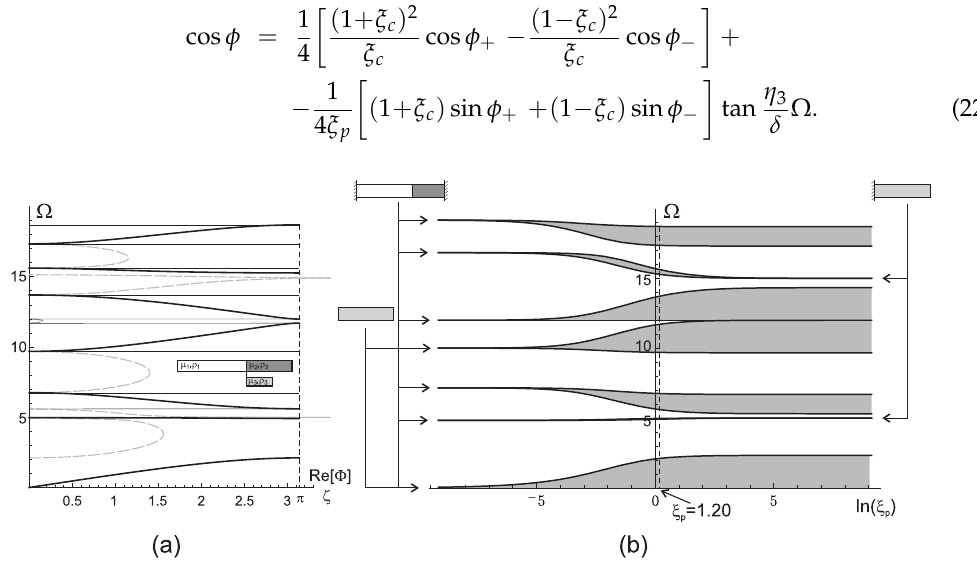
Figure 9. Continuous phase in parallel. Results are given for ξ c = 0.22, η c = 0.5. ( a ) Dispersion curves (continuous black lines) and decay exponent (dashed grey lines) for ξ p = 1.20, η p = 0.60. ( b ) Band distribution, where Ω is given as a function of the impedance ratio ξ p ( η p =